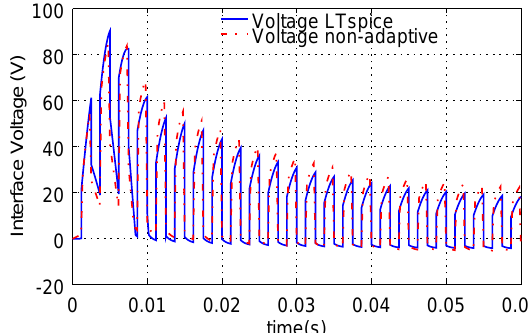
Figure 10: The voltage at interface between the circuit and the field case of low load resistance, a simulation time win- dow of 24 times the transistor switching period is consid-